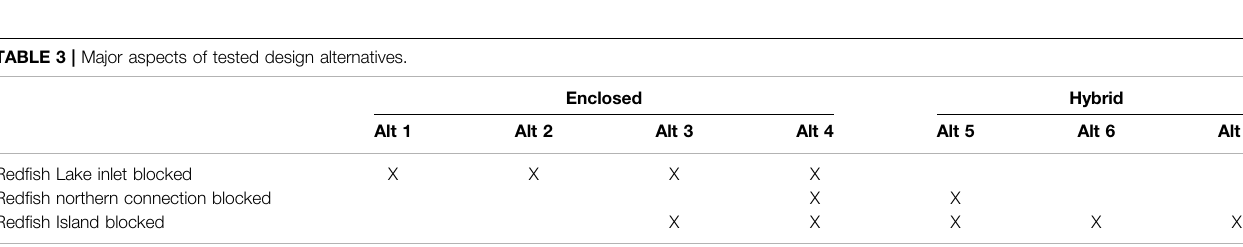
TABLE 3 | Major aspects of tested design